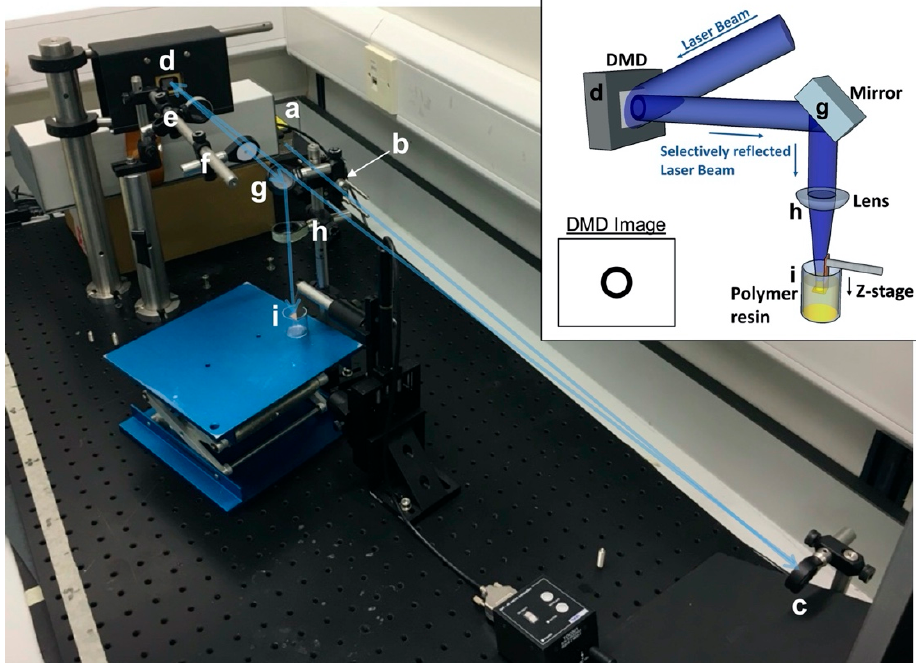
Figure 10. The microstereolithography ( μ SL) set ‐ up. Inset: Schematic of the set ‐ up. An expanded laser beam hits the DMD which selectively reflects the laser beam in the shape of the desired image which is focused on the surface of a vial of prepolymer resin. Example DMD image shown for use in tube production. Main image: The experimental µ SL set ‐ up. A laser beam from source ( a ) is passed through a spatial filter ( b ) and reflected off a mirror ( c ) towards a DMD ( d ). The selectively reflected image from the DMD is passed through a 25 cm focal length lens ( e ) followed by an iris ( f ) to remove multiple images caused by diffraction. The image is then reflected down by a second mirror ( g ) and focused by a 10 cm focal length lens ( h ) onto the stage in the vial of prepolymer resin ( i ). The blue arrow illustrates the laser beam path.